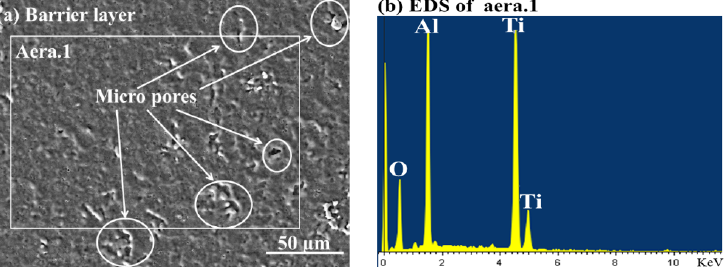
Figure 1. The surface morphology and energy-dispersive spectroscopy (EDS) analysis of the barrier layer.